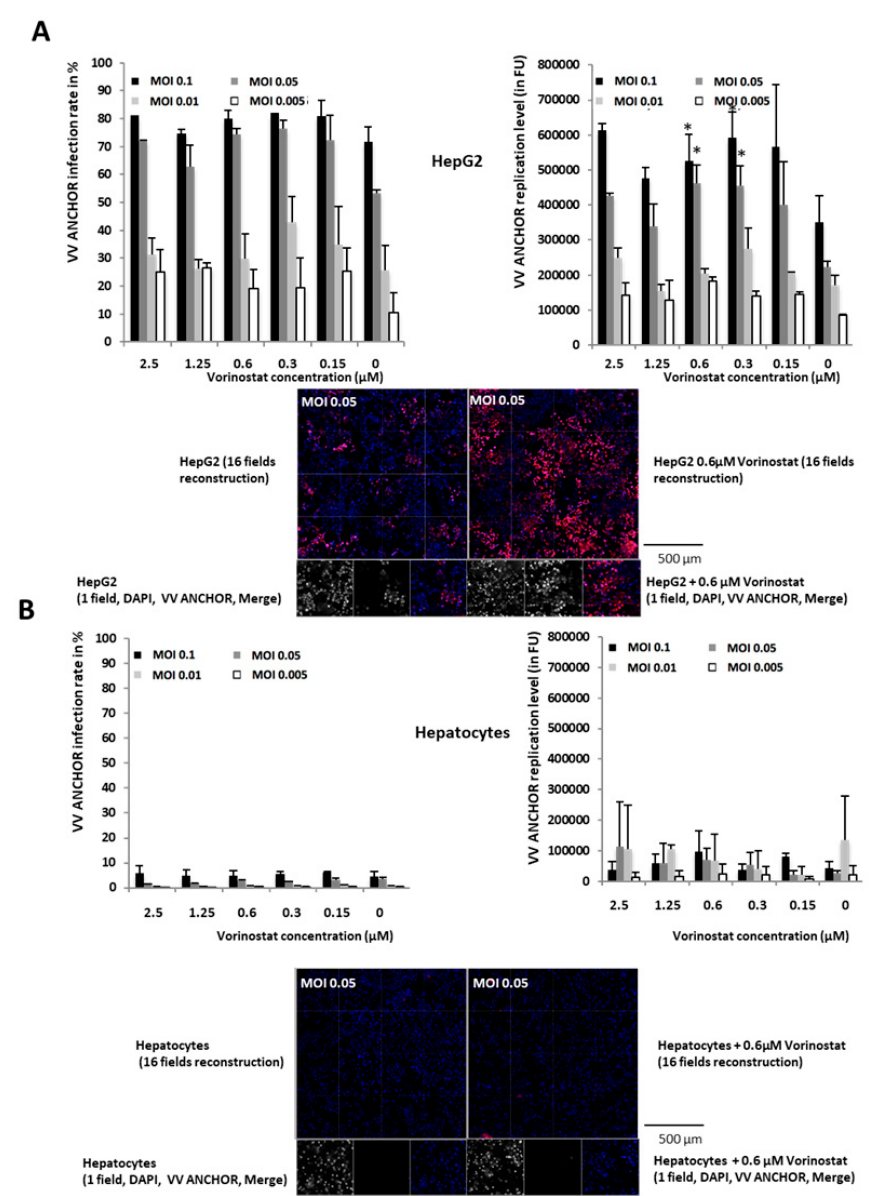
Figure 5. VACV ANCHOR oncolytic potential is restricted to cancerous cells. ( A ) Top: Hep G2 cells were treated with increasing concentrations of vorinostat and immediately infected with the virus at the corresponding MOI. Cells were fixed and processed for high-content imaging (HCI) 48 h post-infection. Results are the average of 3 independent wells ± SD. * p < 0.05 compared to cells infected at the same MOI without vorinostat treatment. Bottom: example of Hep G2 cells infected at MOI 0.05 and left untreated (left) or treated with vorinostat at 0.6 µ M. Either a field reconstruction of 16 frames or a single frame are presented. ( B ) Top: primary hepatocytes were treated with increasing concentrations of vorinostat and immediately infected with the virus at the corresponding MOI. Cells were fixed and processed for HCI 48 h post-infection. Results are an average of 3 independent wells ± SD. Bottom: example of primary hepatocytes infected at MOI 0.05 and left untreated (left) or treated with vorinostat at 0.6 µM. Either a field reconstruction of 16 frames or a single frame are presented.